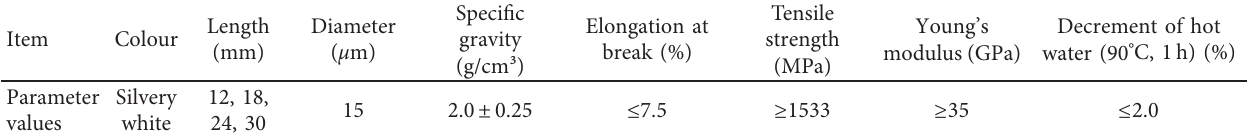
Table 4: Physical properties of PVA fiber